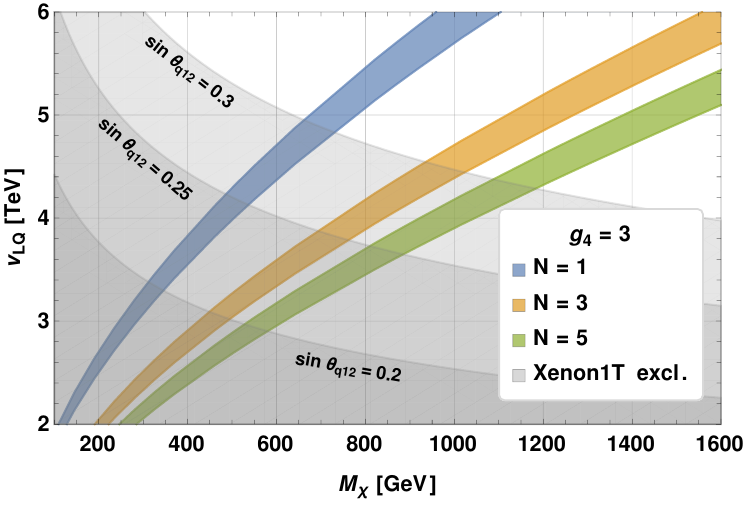
Figure 4 . DM constraints in the M (cid:31) vs. v LQ plane. Colored rays ful(cid:12)ll the (cid:10) 0 h 2 constraint within (cid:6) 15%. Grey regions, with sin (cid:18) q (cid:12)xed at the displayed value, are excluded by Xenon1T [72]. See 12 text for